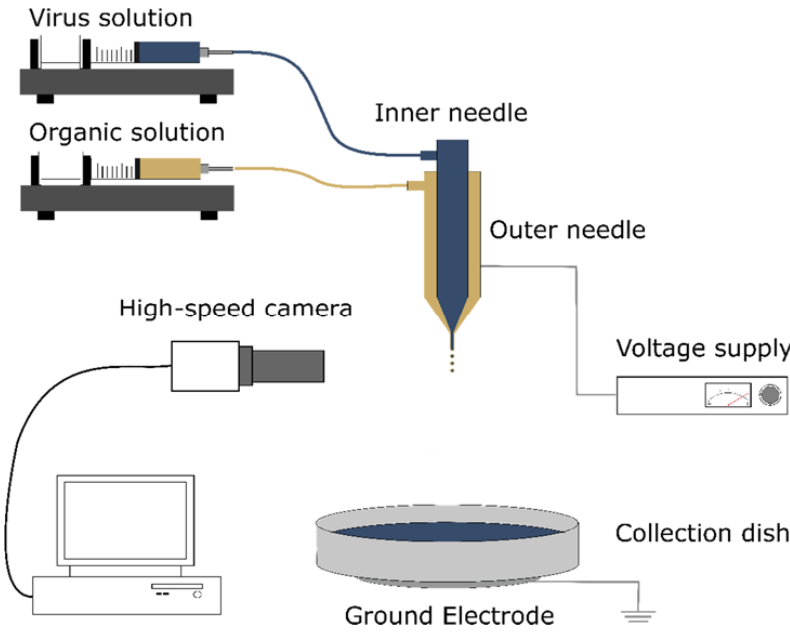
Figure 1. Schematic of the electrospraying rig used for both single and co-axial needle